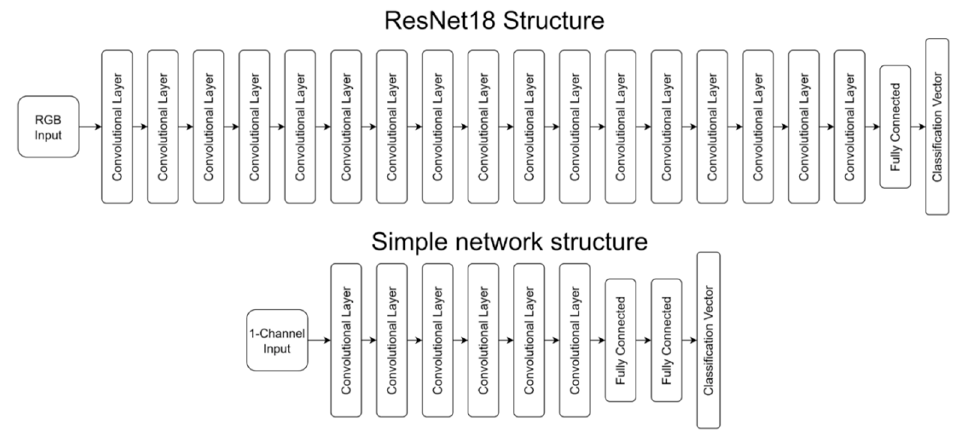
Figure 1. Network structures.